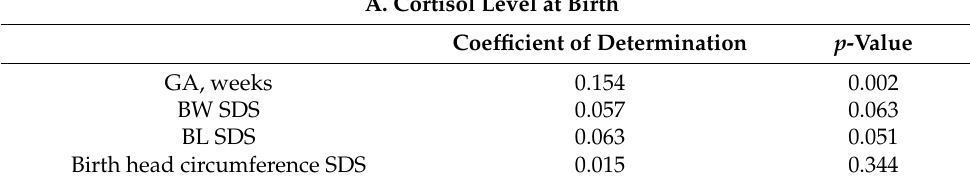
Table 2. Regression